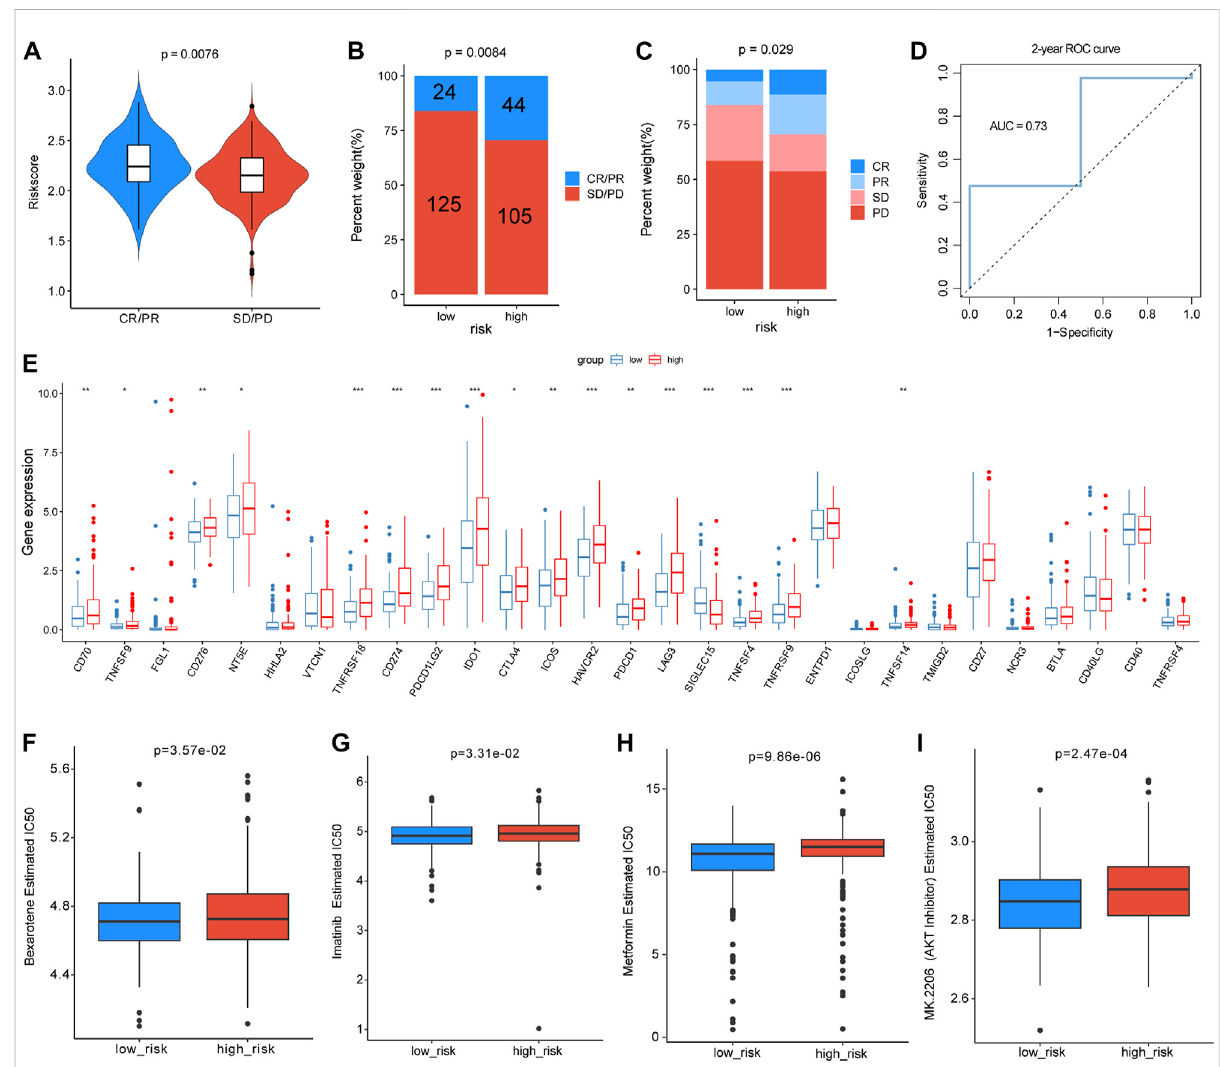
FIGURE 10 Analysesofriskscoresforpredictingimmunotherapyef fi cacyanddrugsensitivity. (A) DistributionoftheriskscorebetweenpatientswithPD/SD and patients with PR/CR in the IMvigor210 dataset. (B,C) Proportion of patients with different immunotherapy responses in different risk groups. (D) Two-year ROC curve for estimating the predictive ef fi cacy of the risk score. (E) Differences in expression levels of immune checkpoints